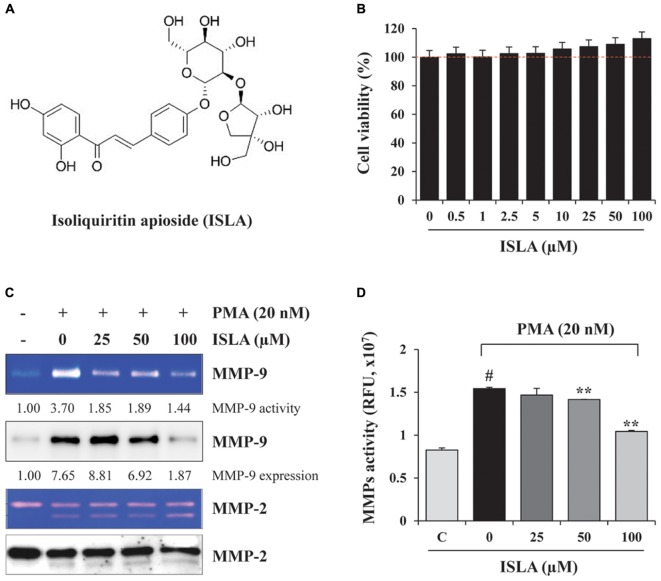
Isoliquiritin apioside (ISLA) at non-cytotoxic doses reduced matrix metalloproteinase (MMP) activity in HT1080 cells. (A) The chemical structure of ISLA. (B) HT1080 cells were incubated with increasing concentrations of ISLA up to 100 μM for 48 h. Relative cell viability compared with untreated control cells was determined by the CCK-8 assay and expressed as the mean ± SD from three independent experiments performed in triplicate. (C) The MMP-9 activity and levels in ISLA-treated and untreated HT1080 conditioned medium (CM) was measured by gelatin zymography and western blotting, respectively. The relative band intensities were calculated using ImageJ software. (D) MMP activity in the ISLA-treated and untreated HT1080 CM was measured using the fluorometric green MMP substrate. Fluorescence intensity monitored at an excitation/emission of 490/525 nm was expressed as the mean ± SD (n = 3 per group). #p < 0.01 vs. untreated control, ∗∗p < 0.01 vs. ISLA-untreated control.